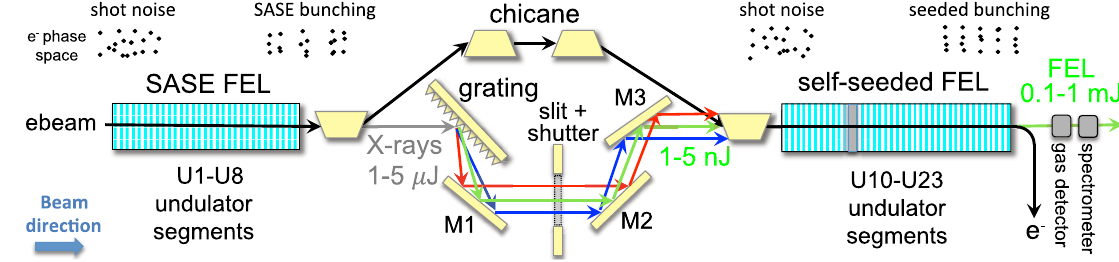
1. Schematic of SXR self-seeding layout at LCLS (not to scale) adapted from Ref. [9]. The SXR self-seeding chicane and monochromator are at undulator segment position U9 while the hard x-ray self-seeding chicane and crystal-based monochromator (neither used in this experiment) are located at position